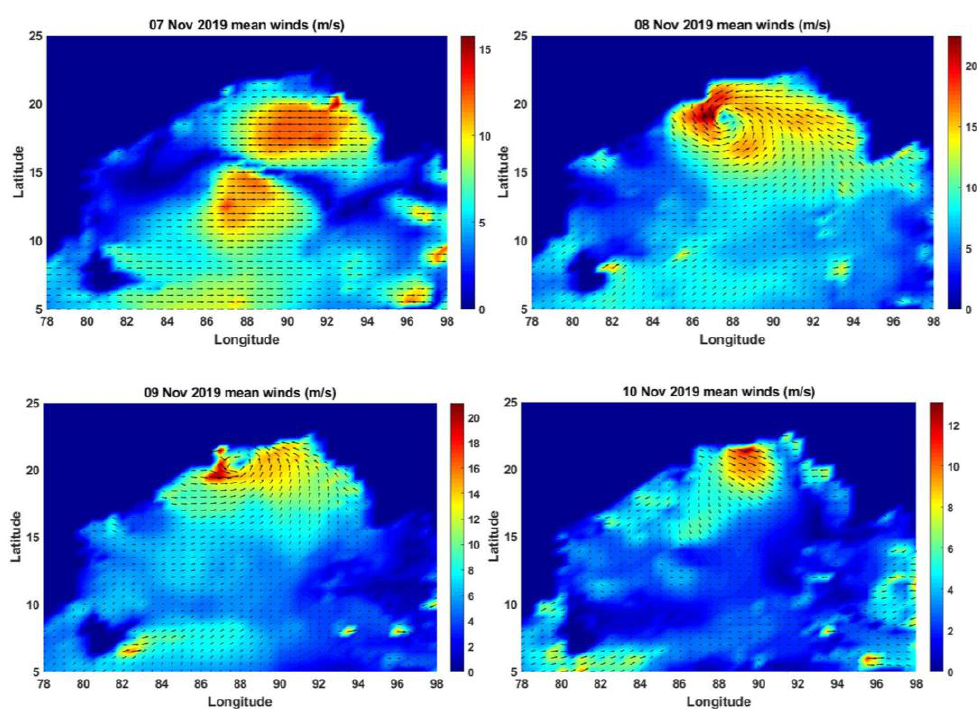
Figure 14. Mean winds (m/s) during BULBUL cyclone (7 – 10 November 2019) from SCATSAT − 1 (25 km) daily products.